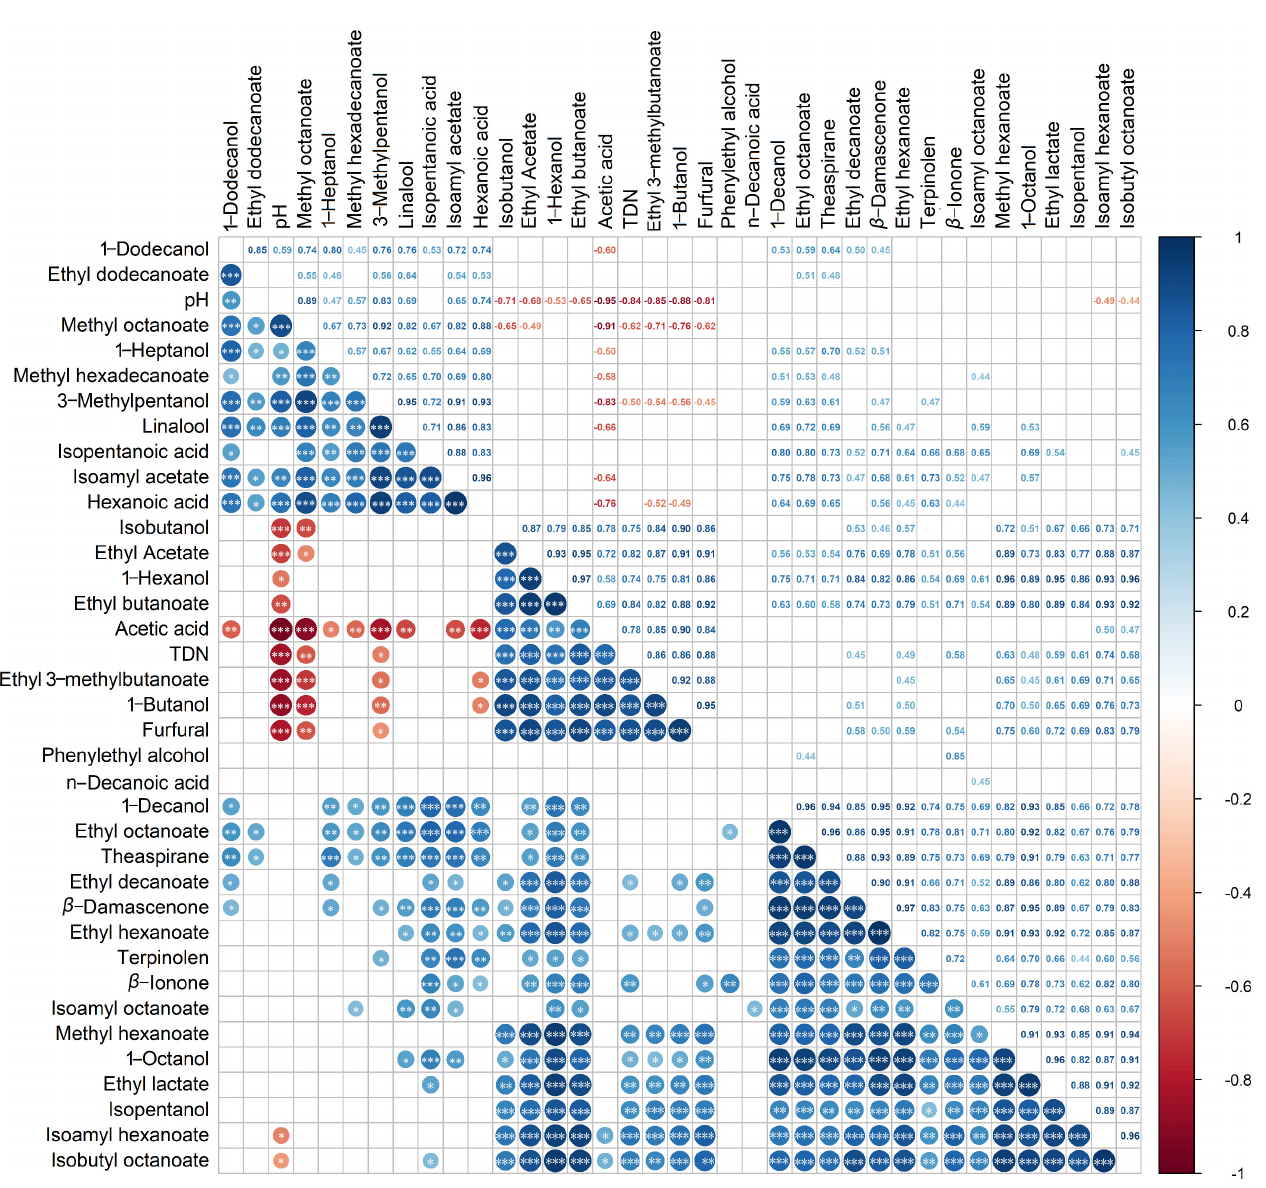
Figure 3. Correlation analyses between the pH value and the concentration of individual aroma compounds and between different aroma compounds. The “*”, “**”, and “***” represented that the correlations were statistically significant, which means p < 0.05, p < 0.01, p < 0.001, respectively.